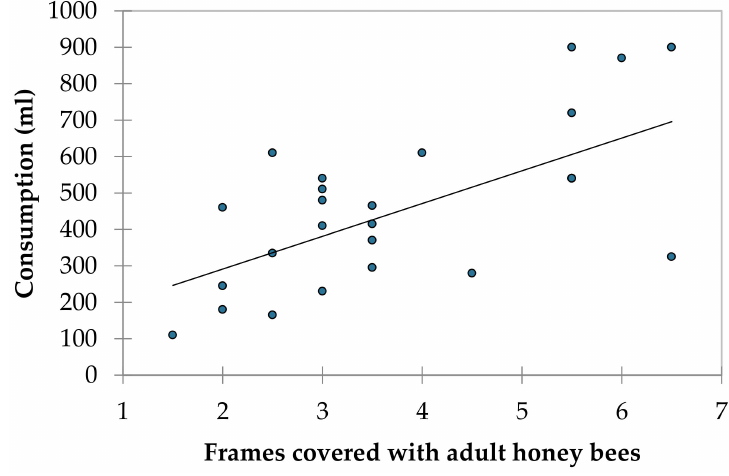
Figure 3. Linear correlation between the number of frames covered by adult honey bees before treatment and OTC syrup consumption (both groups are included in the figure). p -value < 0.0001; R 2 =